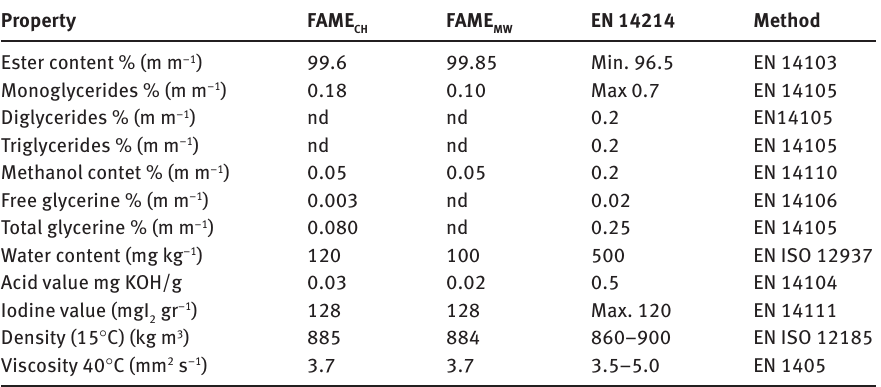
Table 2: The physicochemical properties of methyl esters as final products (for CH: T = 55 ° C after 20 min of the reaction, for MWHCC: T = 55 ° C after 10 min).